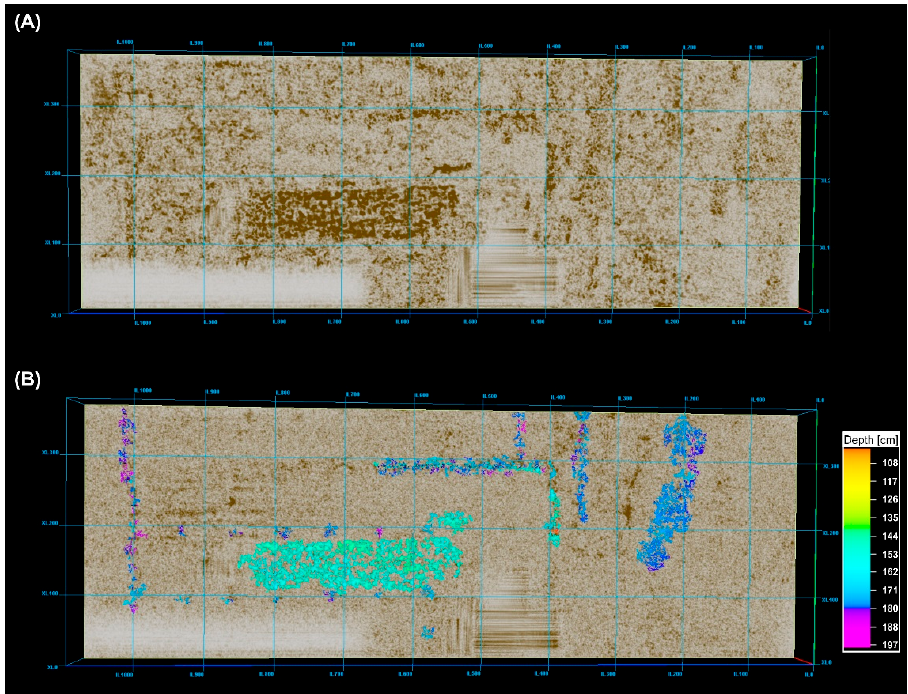
Figure 8. ( A ) Exemplary 145 cm trace envelope depth-slice; ( B ) Results of isosurfaces extraction exploiting the envelope, within the 100–200 cm depth range.